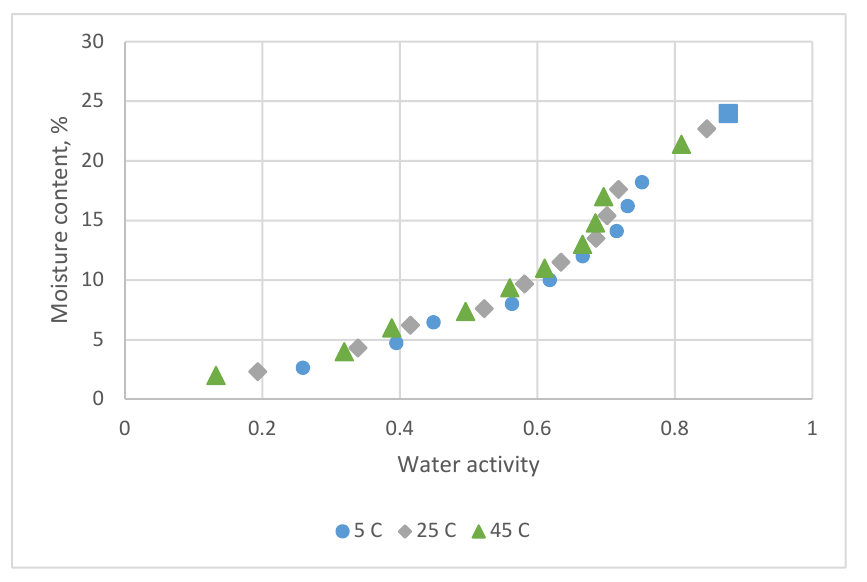
Figure 4. Sorption data for A. formosanus Hayata obtained at 5 °C, 25 °C and 45 °C by the equilibrium relative humidity method.